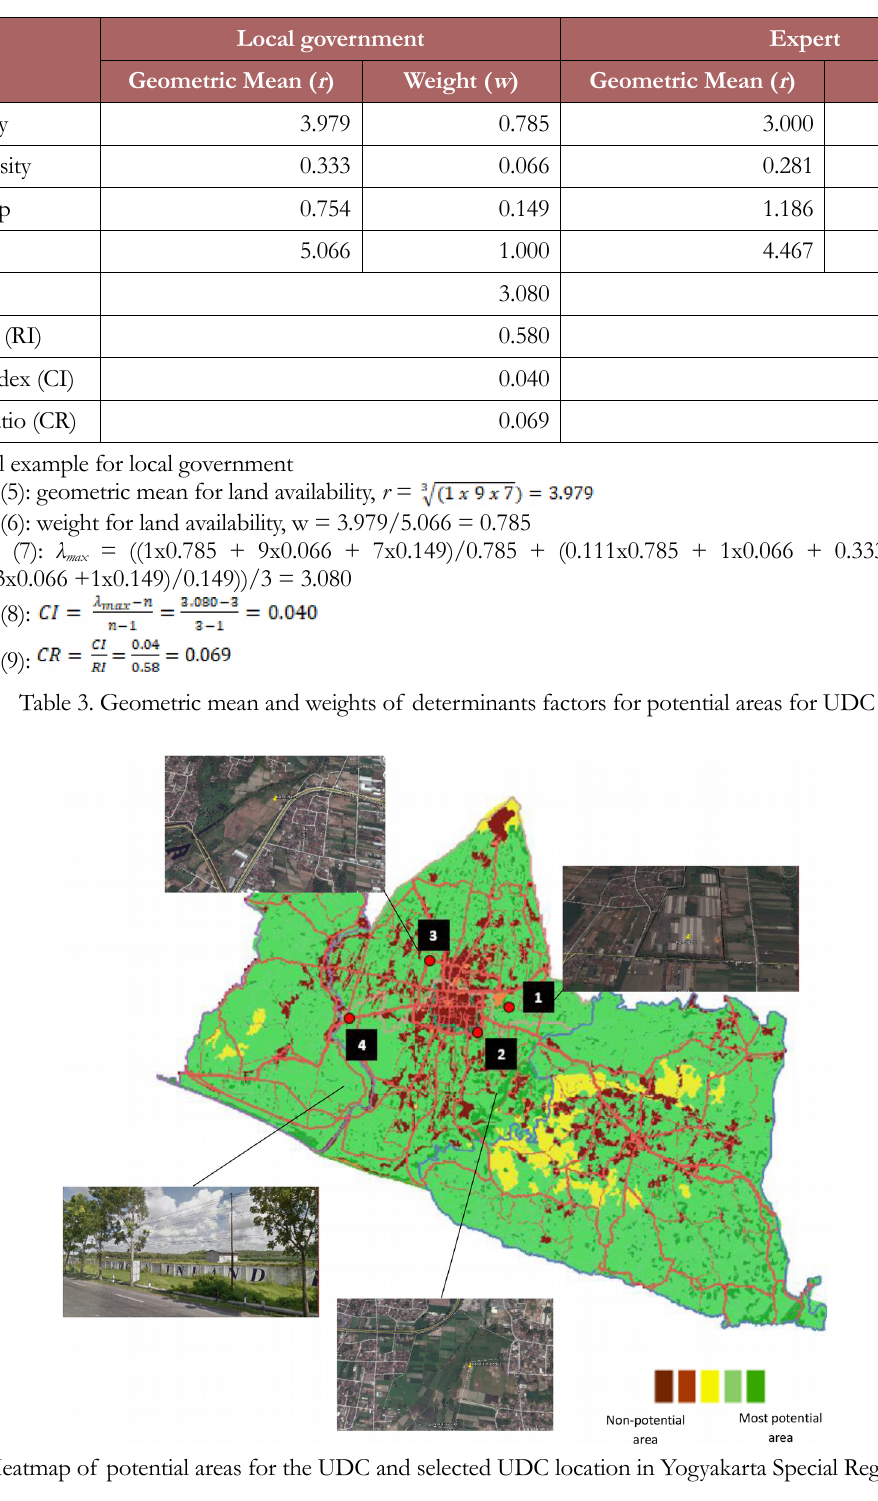
Figure 2. Heatmap of potential areas for the UDC and selected UDC location in Yogyakarta Special Region